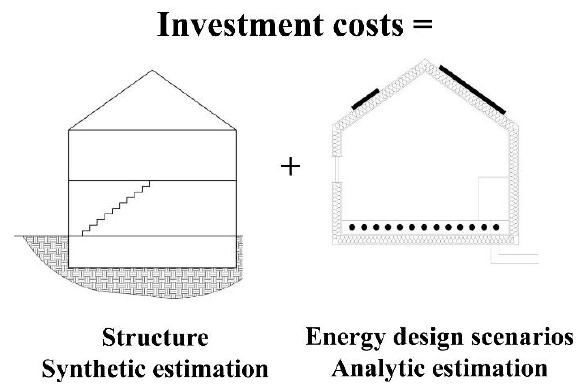
Figure 10. Division of the investment cost